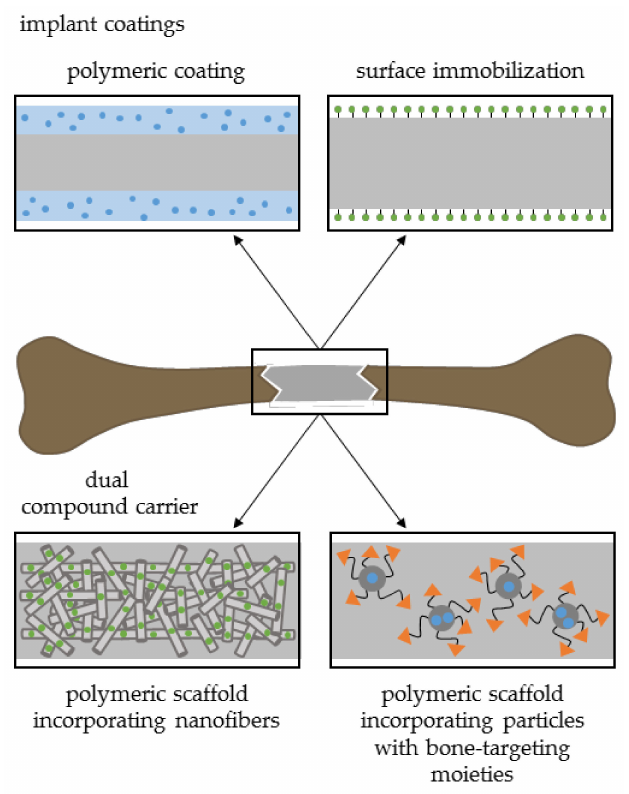
Figure 4. Exemplary sca ff old formulations for bone-targeted drug